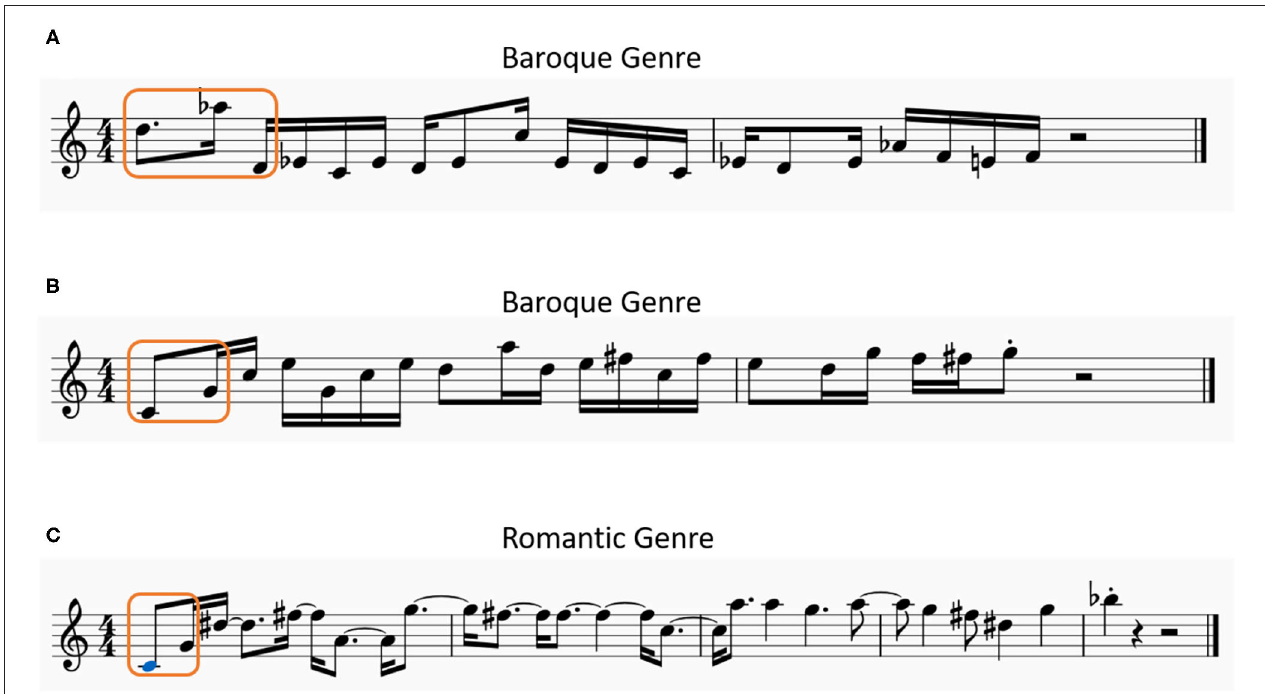
FIGURE 9 | Three examples of melodies generated by the model, (A,B) have the same genre but begin with different seed notes, (B,C) are generated by the same seed notes but with the different genre